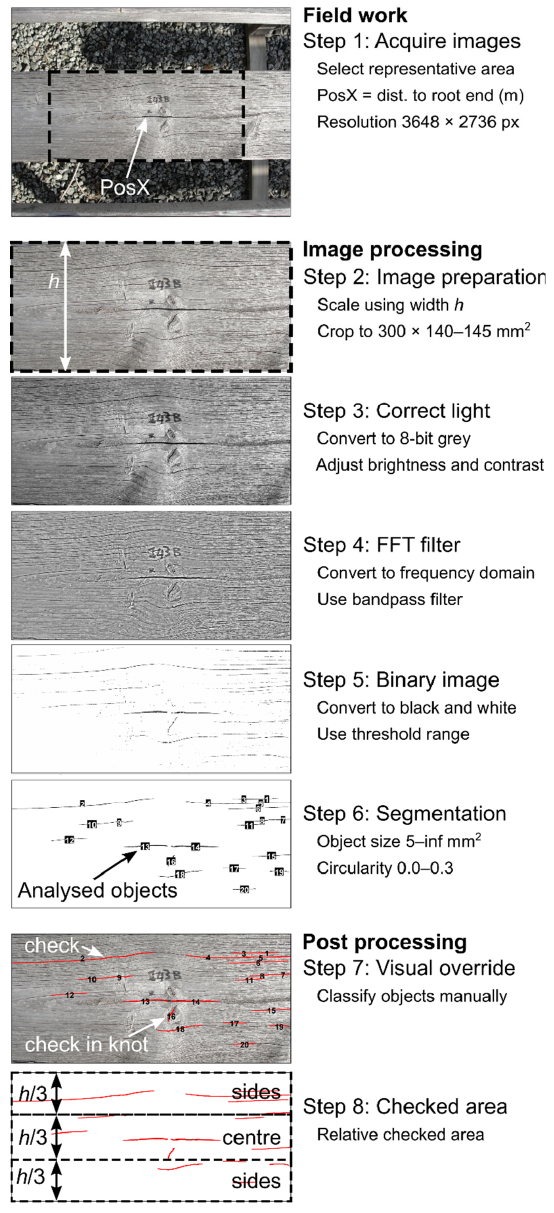
Figure 3. Checking measured by means of a digital image processing method involving 8